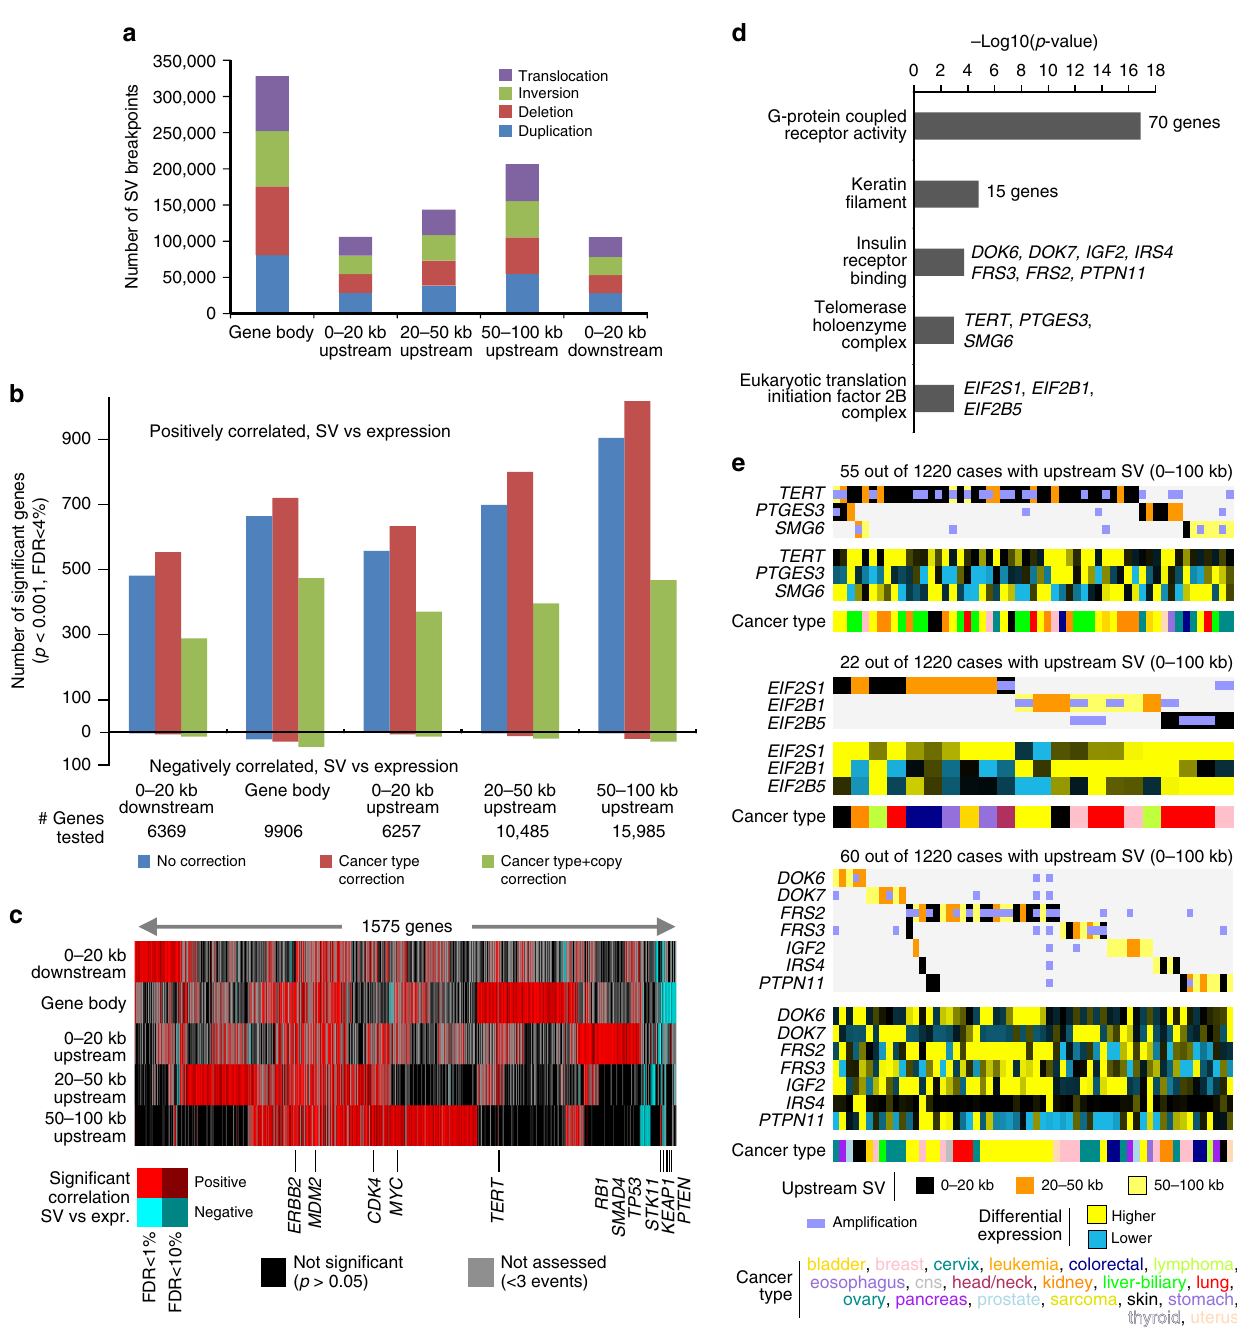
Fig. 1 Structural Variant (SV) breakpoints associated with altered expression of nearby genes. a Numbers of SV breakpoints identi fi ed as occurring within a gene body, 0 – 20 kb upstream of a gene, 20 – 50 kb upstream of a gene, 50 – 100 kb upstream of a gene, or 0 – 20 kb downstream of a gene. For each SV set, the breakdown by alteration class is indicated. SVs with breakpoints located within a given gene are not included in the other upstream or downstream SV sets for that same gene. b For each of the SV sets from part ( a ), numbers of signi fi cant genes ( p < 0.001, FDR < 4%), showing correlation between expression and associated SV event. Numbers above and below zero point of y -axis denote positively and negatively correlated genes, respectively. Linear regression models also evaluated signi fi cant associations when correcting for cancer type (red) and for both cancer type and gene copy number (green). c Heat map of signi fi cance patterns for genes from part ( b ) (from the model correcting for both cancer type and gene copy number). Red, signi fi cant positive correlation; blue, signi fi cant negative correlation; black, not signi fi cant ( p > 0.05); gray, not assessed (<3 SV events for given gene in the given genomic region). d Signi fi cantly enriched Gene Ontology (GO) terms for genes positively correlated ( p < 0.001 and FDR < 4%) with occurrence of SV upstream of the gene (for either 0 – 20 kb, 20 – 50 kb, or 50 – 100 kb SV sets). P -values by one-sided Fisher ’ s exact test. e Patterns of SV versus expression for selected gene sets from part ( d ) (telomerase holoenzyme complex, top; eukaryotic translation initiation factor 2B complex, middle; insulin receptor binding, bottom). Differential gene expression patterns relative to the median across sample pro fi les. See also Supplementary Data 1, 2 and Supplementary Fig.